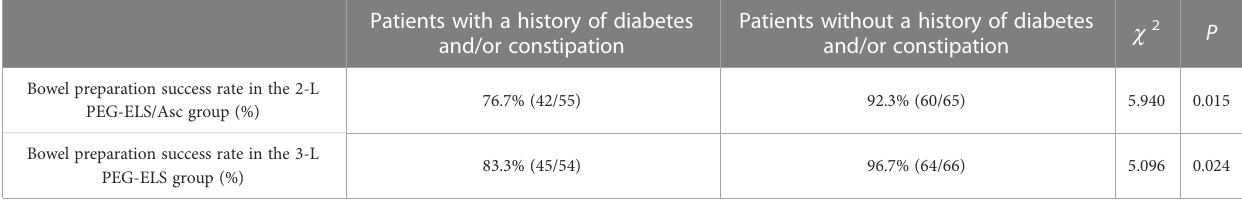
Patients with a history of diabetes Patients without a history of diabetes c 2 P and/or constipation and/or constipation